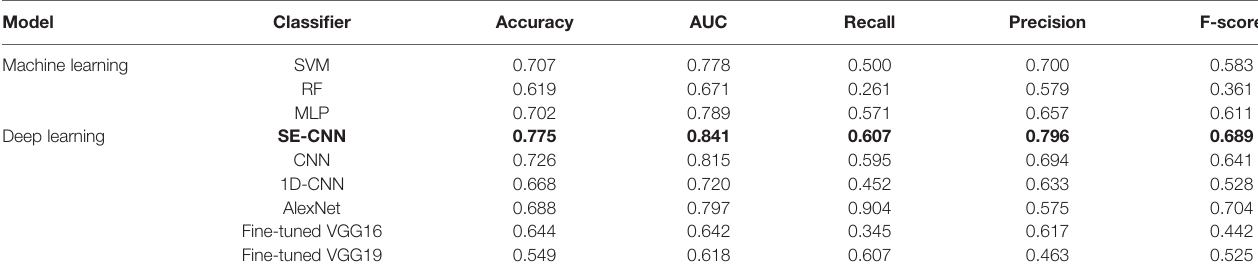
TABLE 3 | Predictive performance of machine learning models using radiomics features (SVM, RF, MLP), and the deep learning models (SE-CNN CNN, AlexNet, Fine- tuned VGG16, and Fine-tuned VGG19) for the external test cohort of 205 patients.